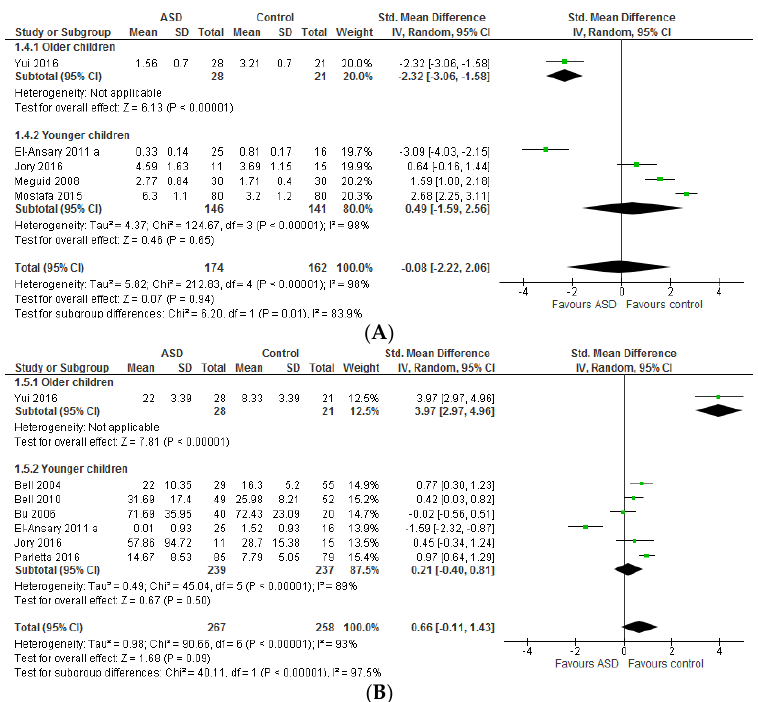
Figure 3. Forest plots of mean (95% confidence interval (CI)) weighted difference in the ratio of arachidonic acid (ARA) to docosahexaenoic acid (DHA) ( A ) and the ratio of ARA to eicosapentaenoic acid (EPA) ( B ) between populations with Autism Spectrum Disorder (ASD) and typically developing children stratified for subgroups with studies including all age groups (children, teenagers, and adults) vs. young children only. Direction of effect (negative, lower mean in ASD group; positive, lower mean in control group; zero, no difference between groups).